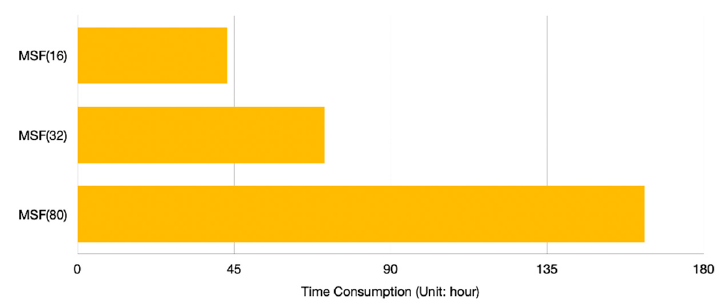
Figure 13. Time consumption of different MSF.